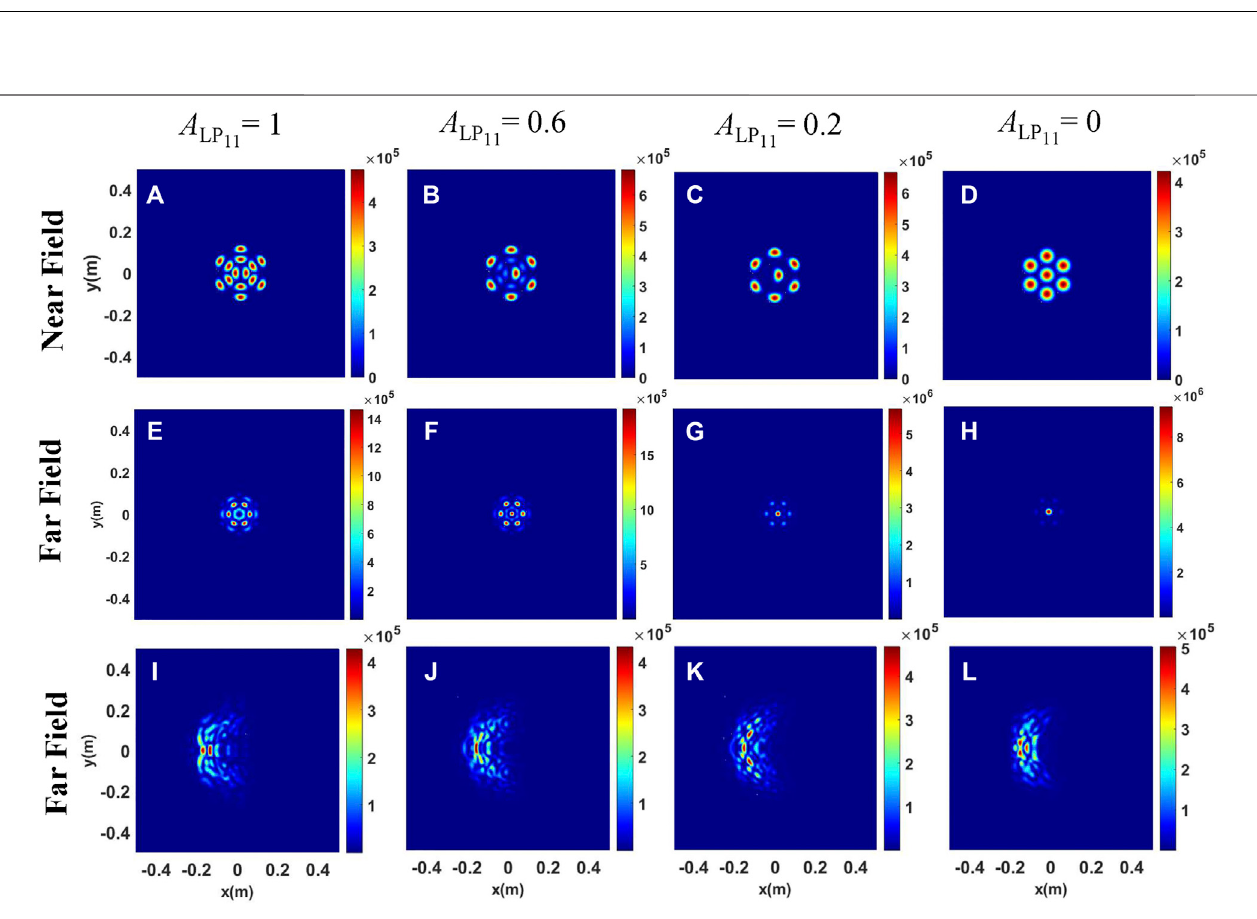
FIGURE 7 | Intensity distributions of the mixed-mode beam array for different content of the LP 01 mode. (A – D) Intensity distributions at the initial plane; (E – H) Intensity distributions at the receiver plane in free space; (I – L) Intensity distributions at the receiver plane under the conditions of thermal blooming.